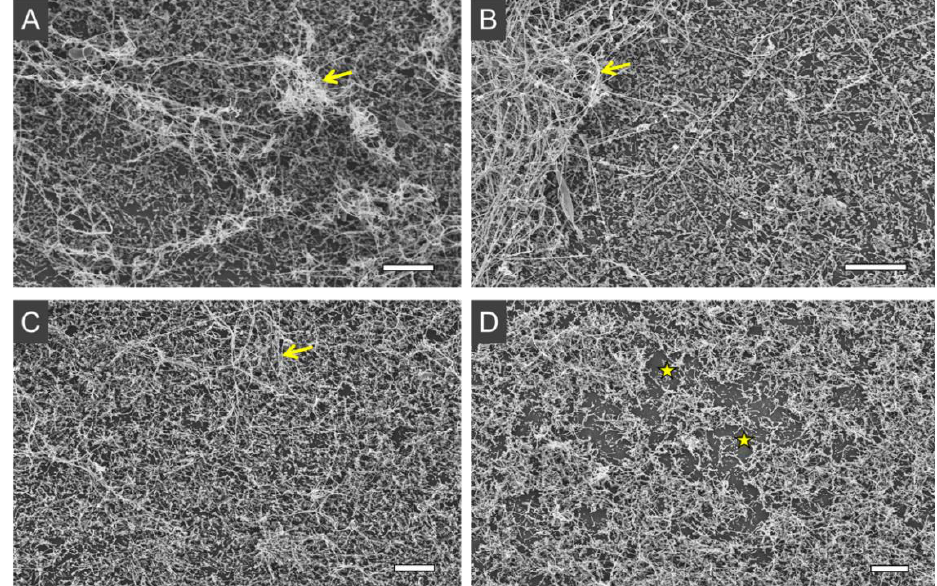
Figure 4. Representative SEM images of C. albicans ATCC 90028 biofilms grown for 48 h and sub- mitted to different treatments. Control ( A ): biofilm without irradiation; dark ( B ): biofilm incubated with 1.5 µM of ZnP hexyl without irradiation; light ( C ): biofilm irradiated only (4.3 J/cm 2 ); aPDI ( D ): biofilm incubated with 0.8 µM of ZnP hexyl for 10 min prior to irradiation (4.3 J/cm 2 ). Yellow arrows indicate hyphae entanglements. Yellow stars indicate the exposed substrate.